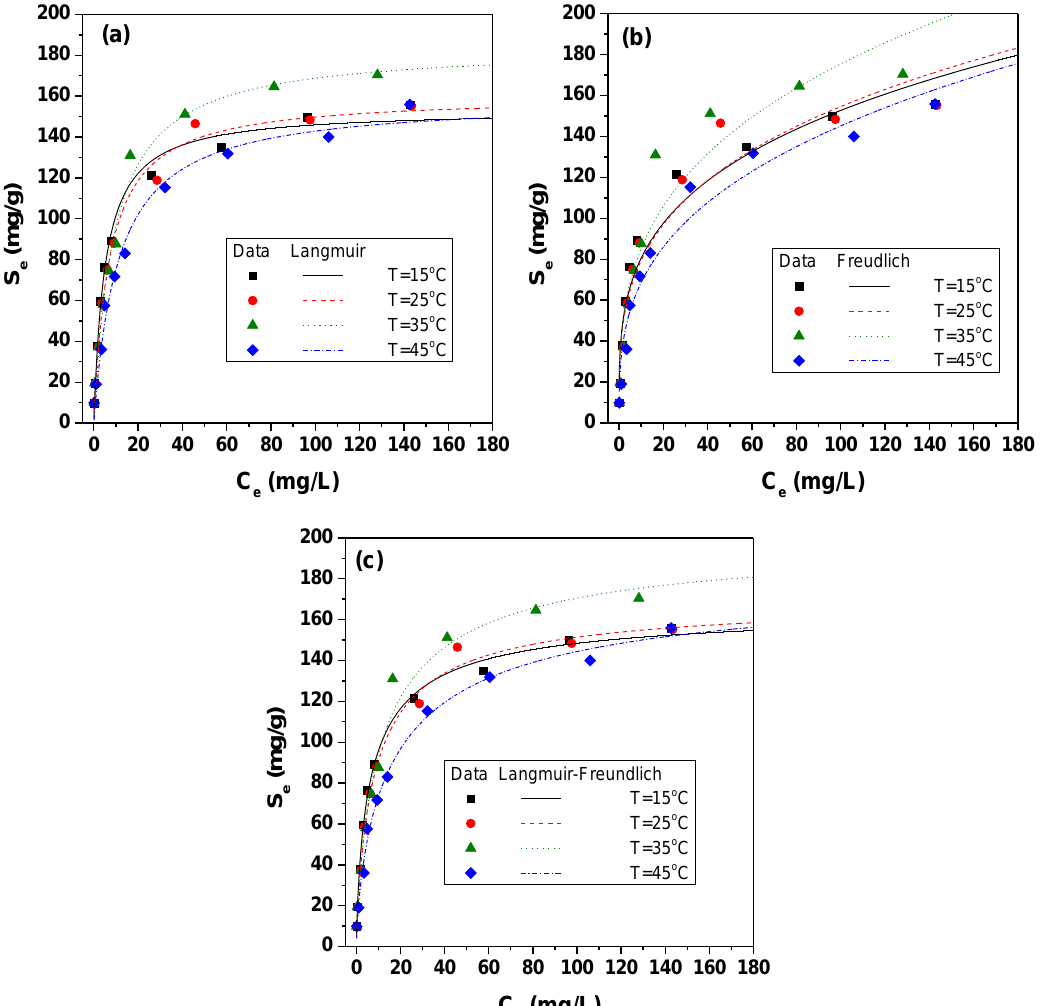
Figure 3. Experimental vs. predicted isotherms of MB sorption onto BP grains. ( a ) Langmuir model. ( b ) Freundlich model. ( c ) Langmuir–Freundlich model.